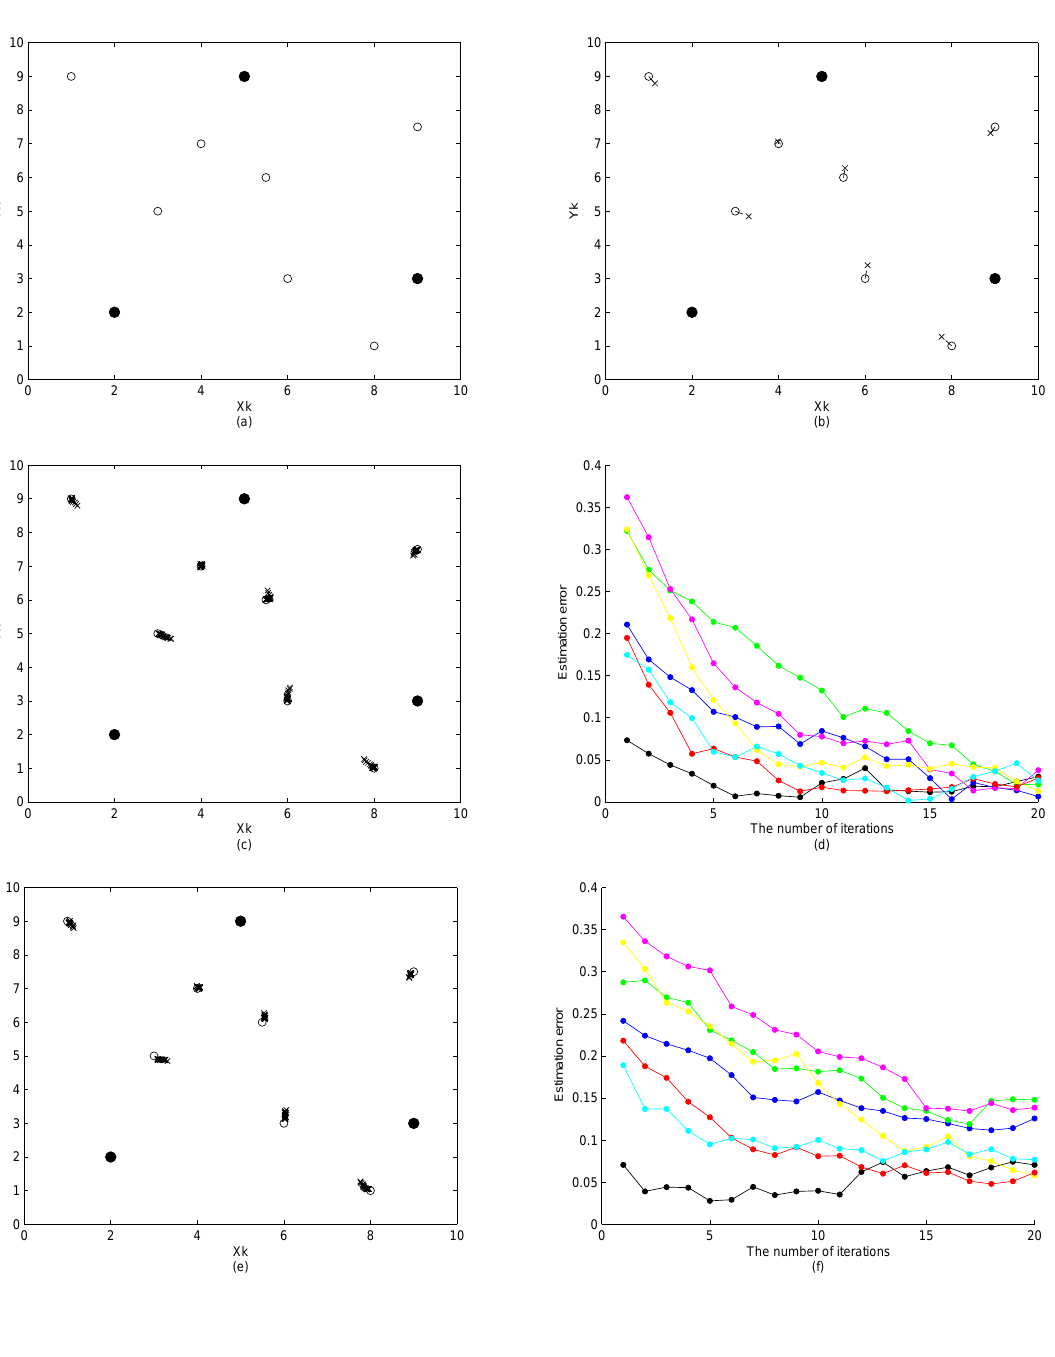
Figure 12. (a)(b) demonstrate the initial position estimation; (c)(d) show the sensor location adjustment and the estimation error by using distance information and proposal density I without resampling; (e)(f) show the sensor location adjustment and the estimation error by using distance information and proposal density II without resampling, where σ 2 = 0 . 5 ε